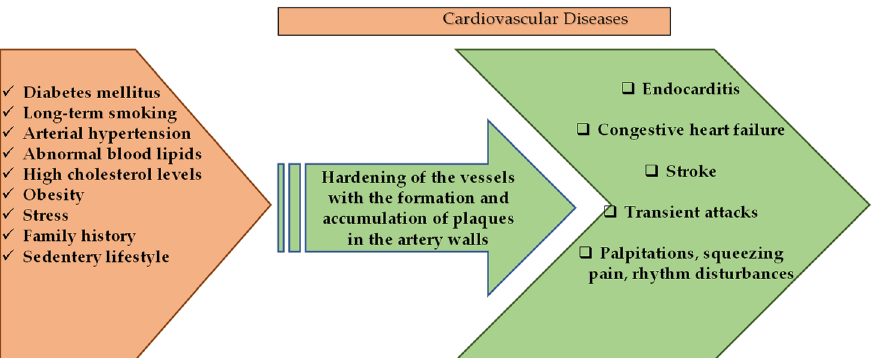
Figure 2. Schematic presentation of cardiovascular diseases and general factors involved in their pathology.